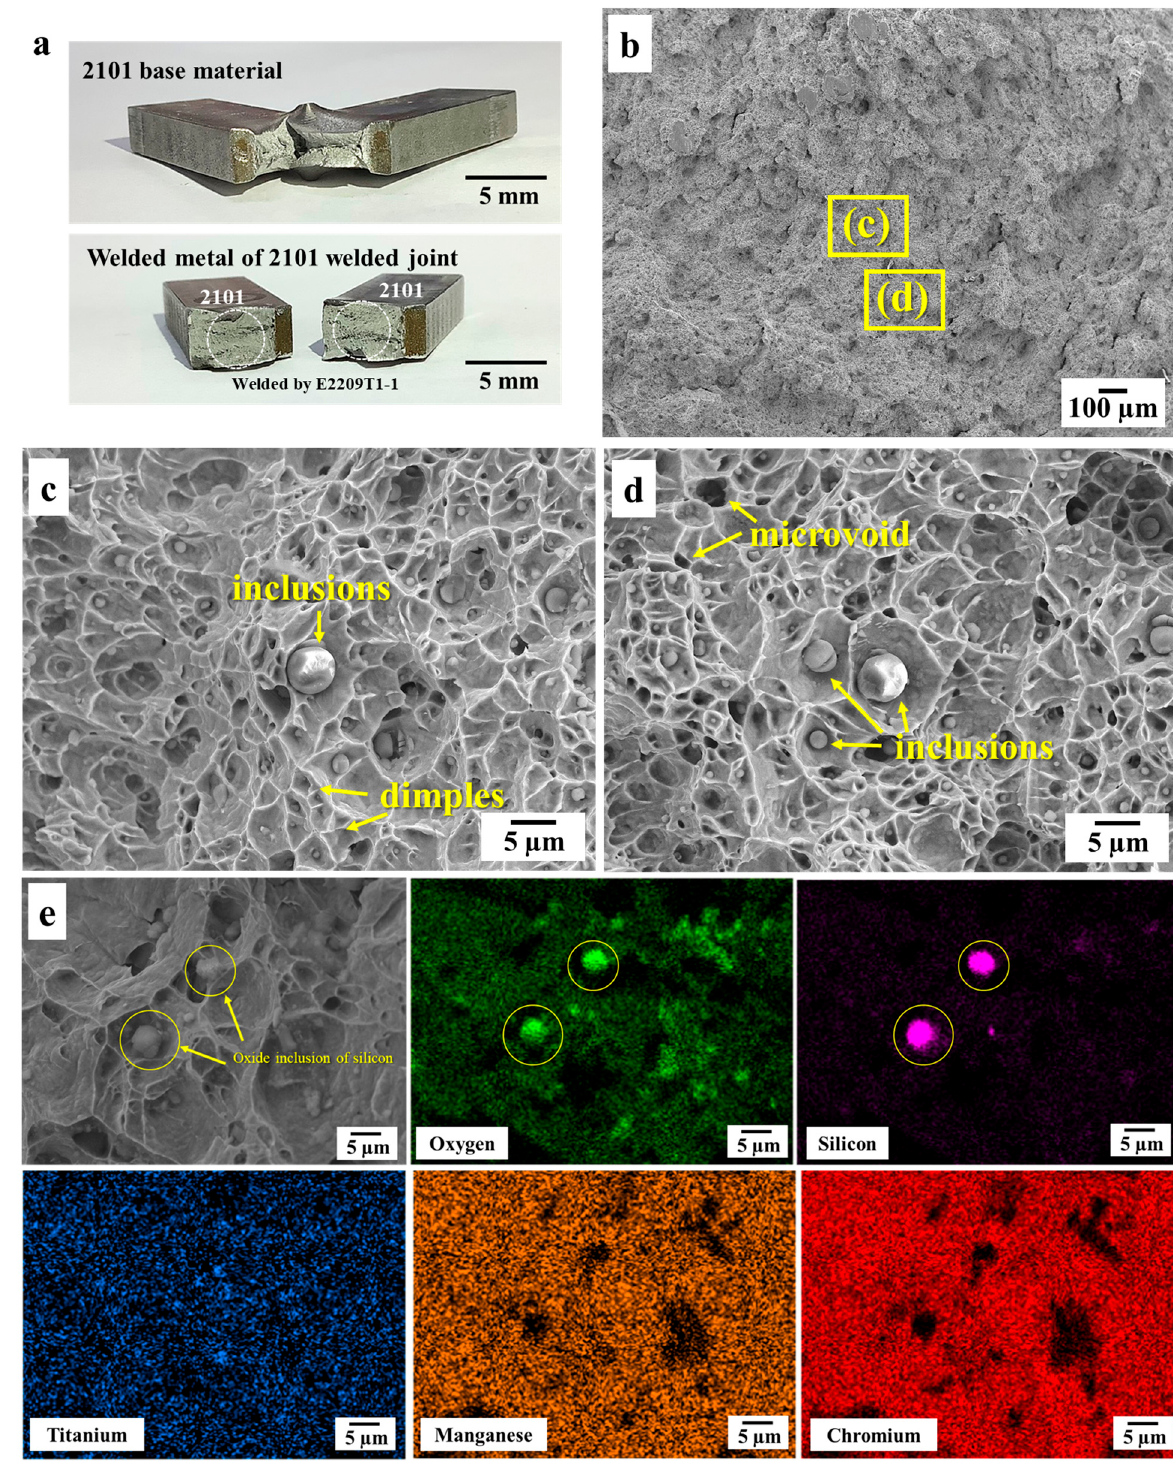
Figure 5. Schematic showing the ( a ) fracture location after the impact test; ( b ) fracture surface micrographs of the welded joints at 60× magnification with areas of interest ( c,d ); ( c , d ) fracture surfaces at 2000× magnification; ( e ) SEM fracture surfaces with EDS mapping.